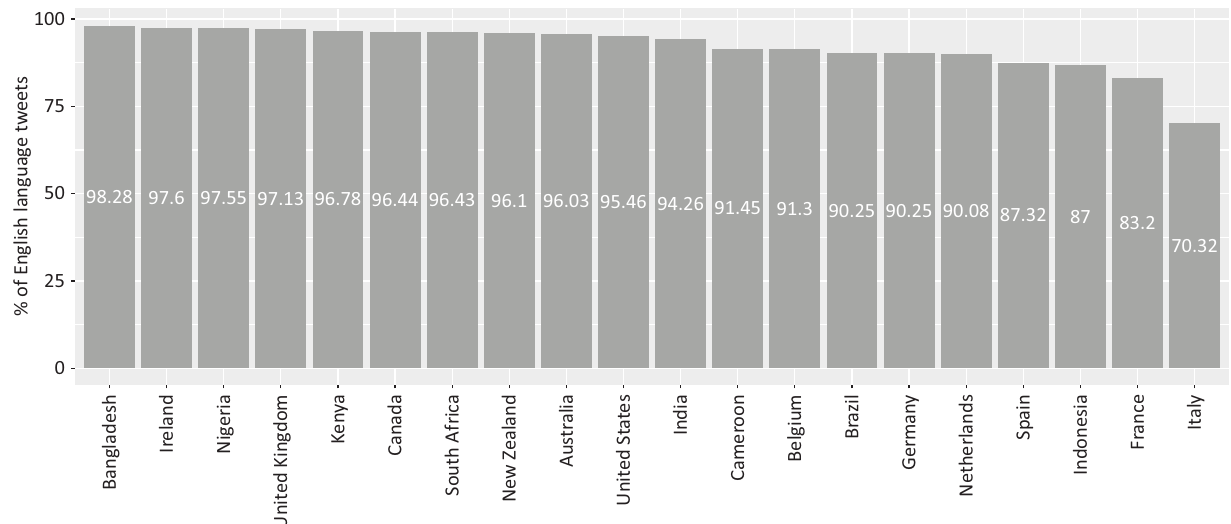
Figure 2. Percentages of English language tweets by country. Notes: Only the 20 most frequent countries in the dataset were included. Values for the detected language of a tweet were directly taken from the metadata provided by